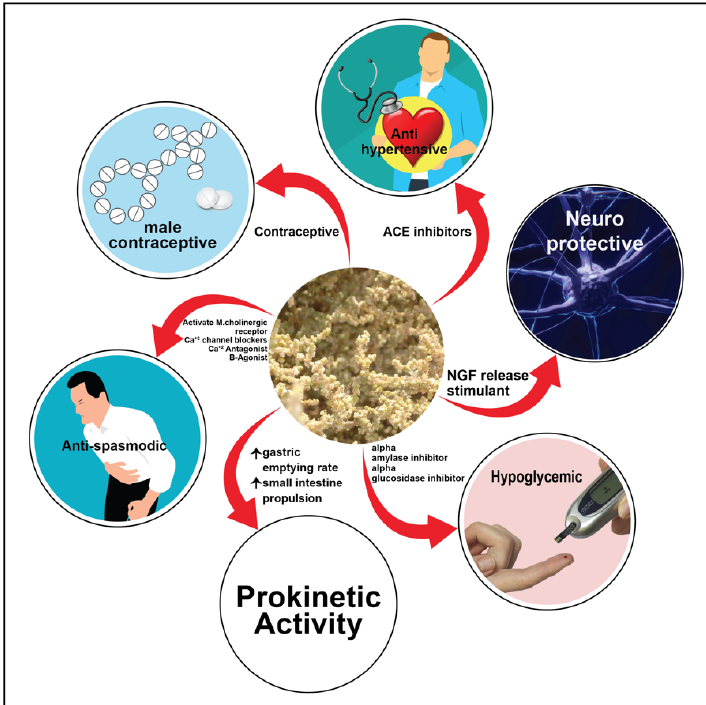
Figure 18. Some important biological activities of genus Salsola and their mechanism.